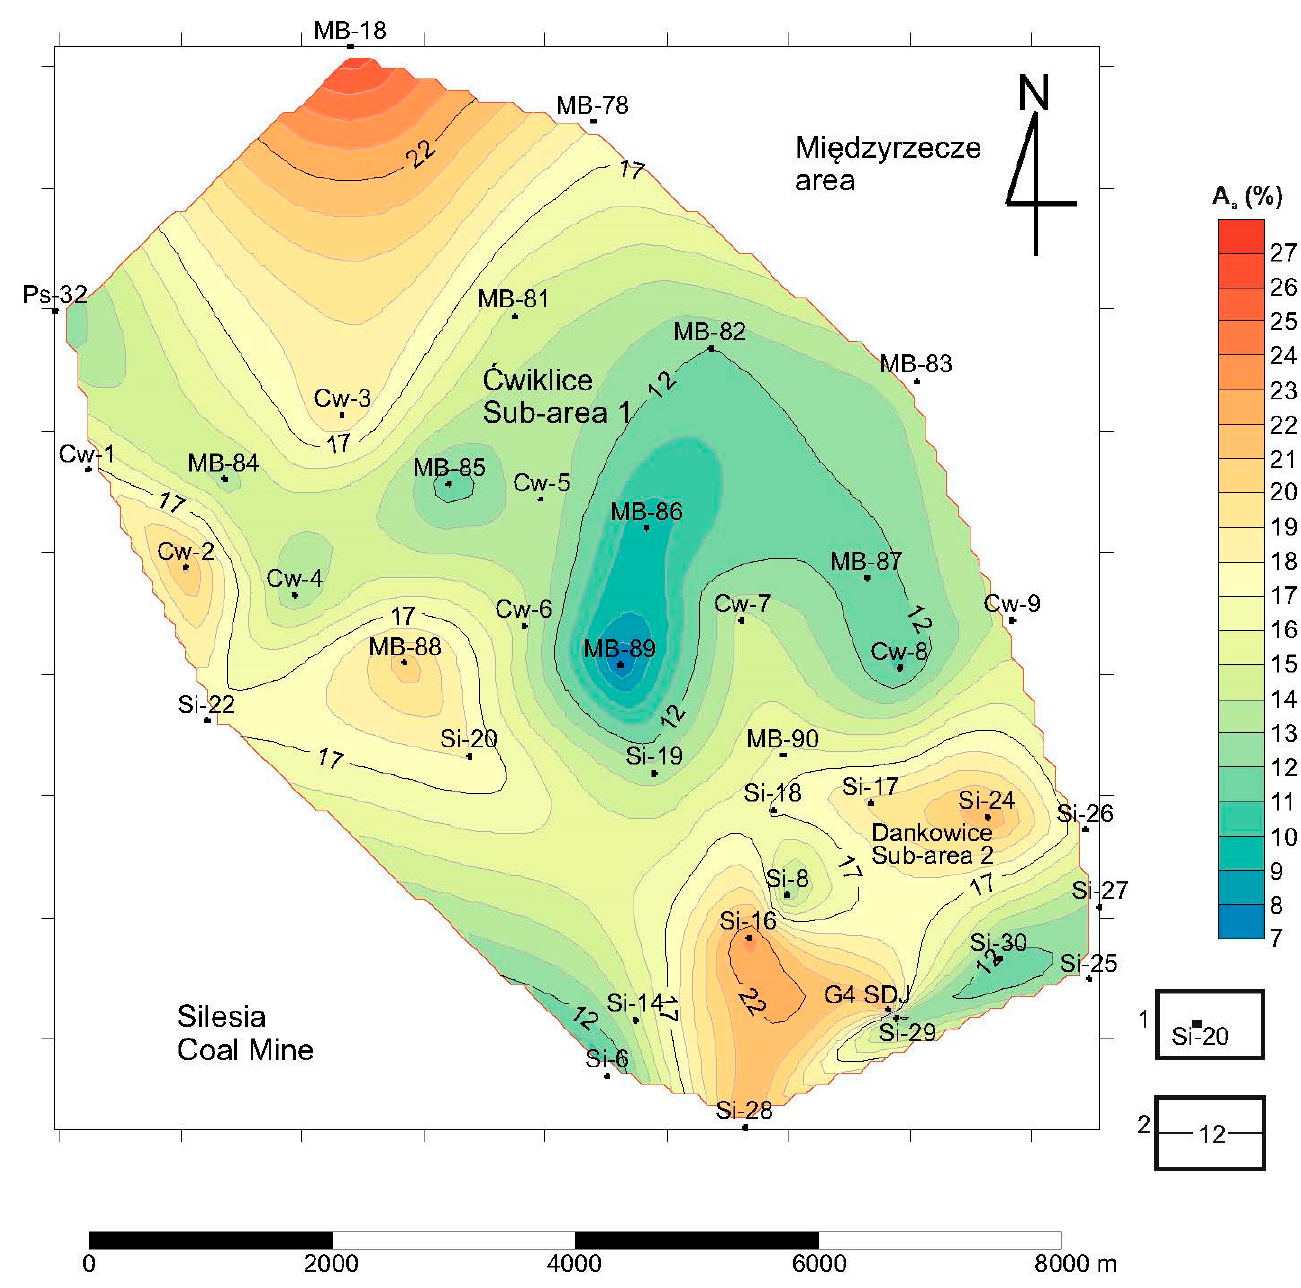
Figure 9. Ash content (A a ) distribution at the 800 m level below ground; 1—borehole, 2—important